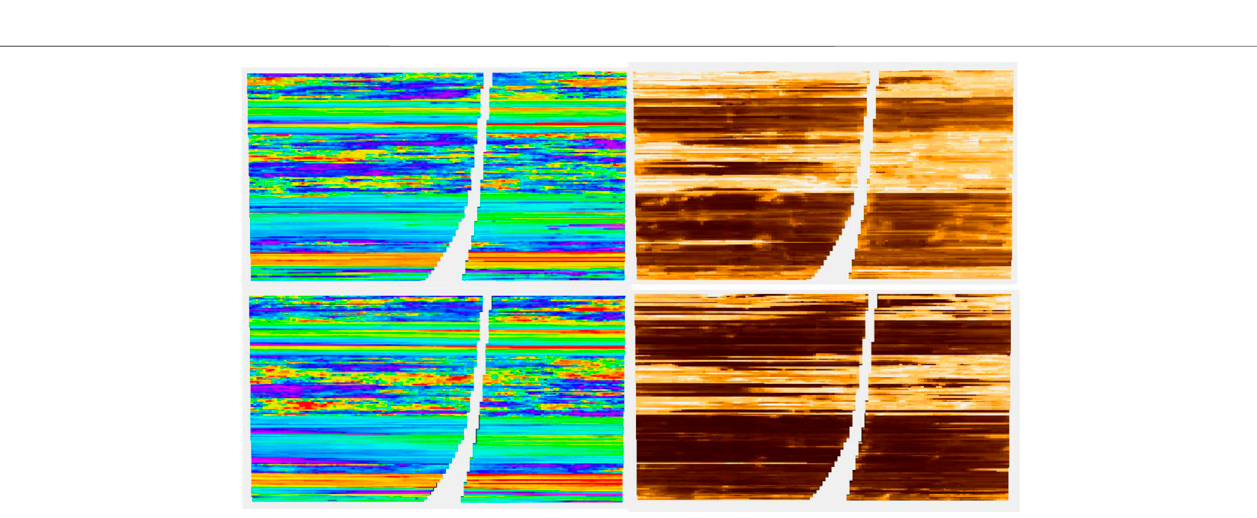
FIGURE 12 | Same result as in Figure 15 , with short-range variogram. Ember is shown on the left. Gaussian is shown on the right. Notice that the Gaussian envelope is almost uninformative compared to Ember.